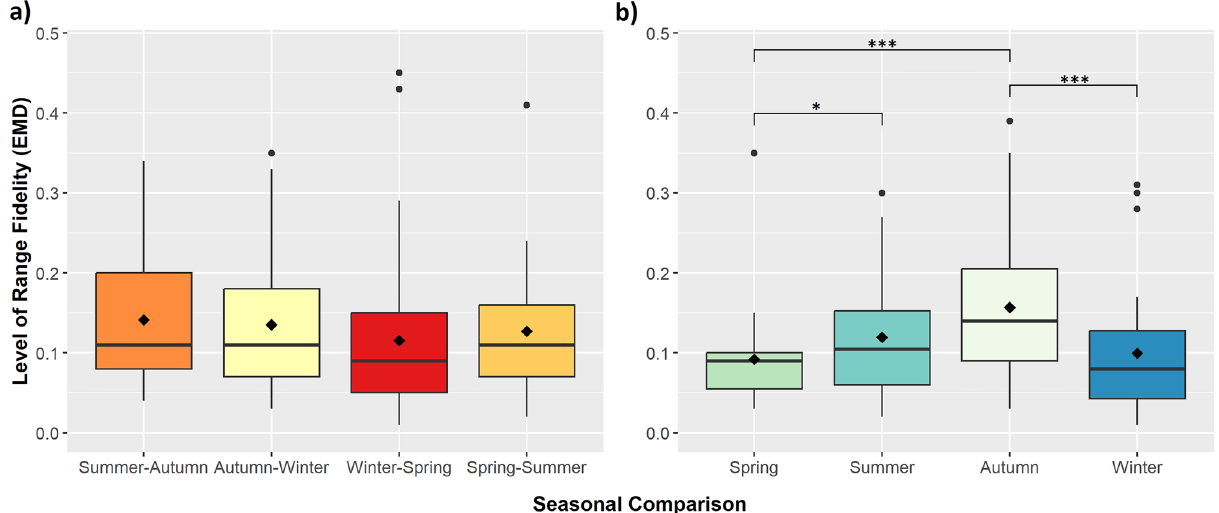
Figure 3. Seasonal space use comparisons of elephants in KNP for ( a ) consecutive seasons within the same year and ( b ) the same seasons between consecutive years. Means are indicated by the ◊ symbol. Significant